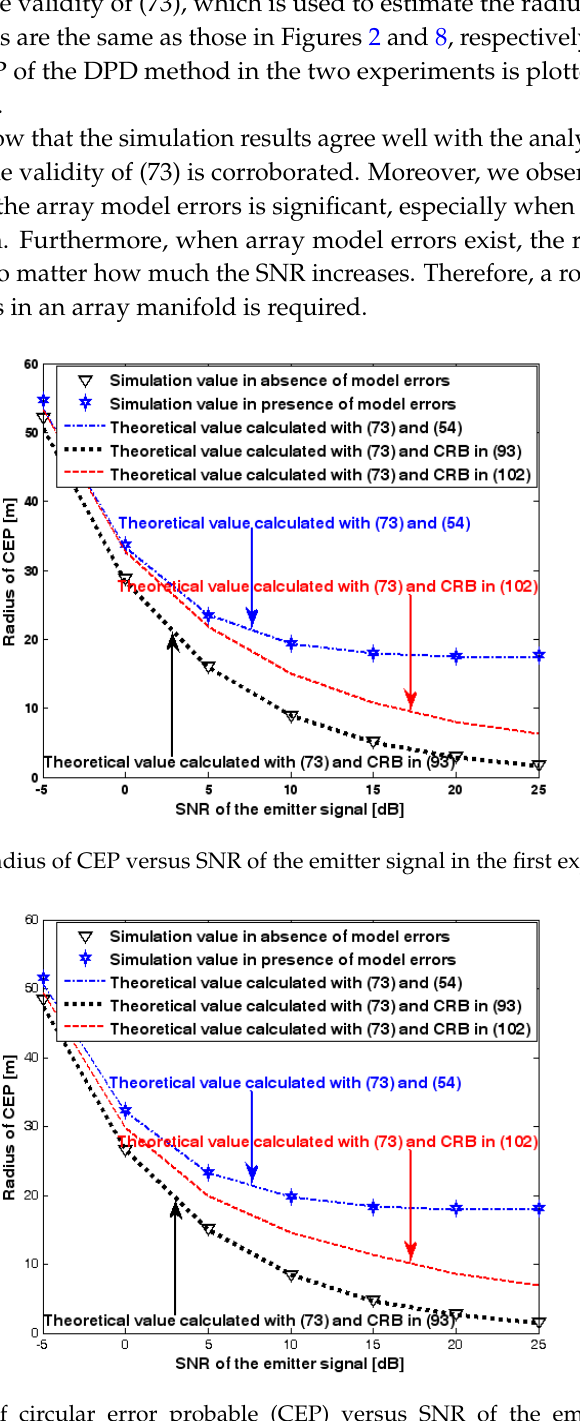
Figure 18. SP of localization as a function of number of snapshots. ( a ) The first SP of localization as a function of number of snapshots. ( b ) The second SP of localization as a function of number of snapshots.